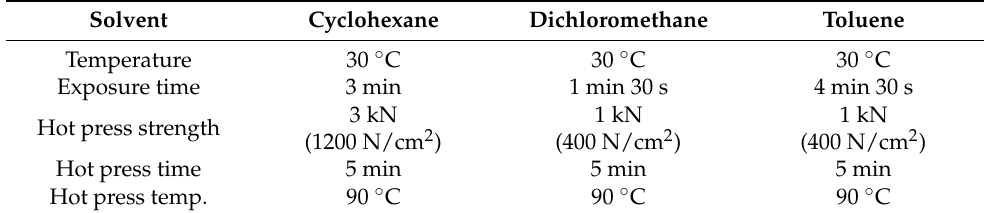
Table 1. Parameters of the solvent-bonding